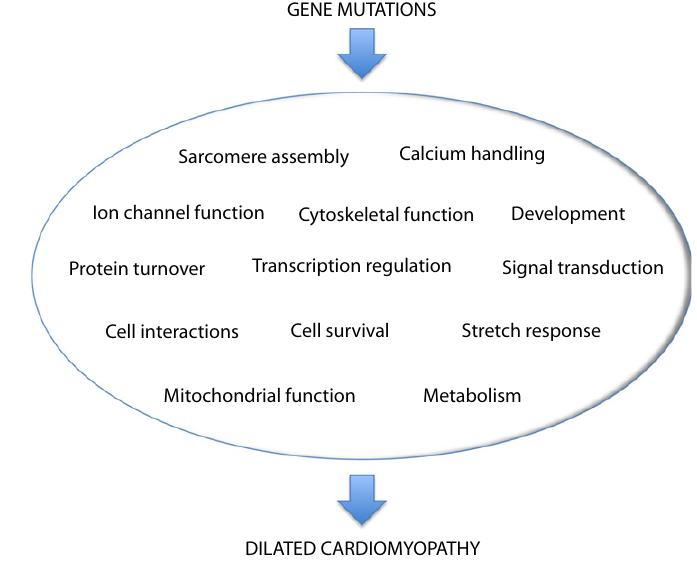
Figure 3. Molecular defects associated with familial DCM. Schematic showing that pathogenic gene variants in families can promote DCM by perturbing diverse aspects of cardiac myocyte structure and function. members with left ventricular dilation will progress to DCM within a 5-year period [25,26].